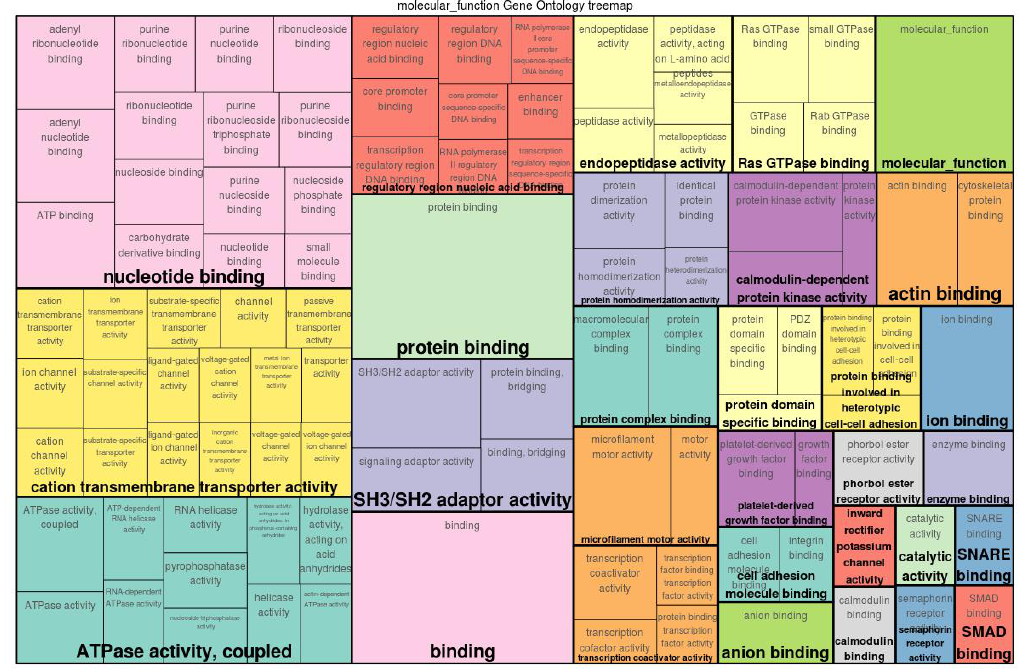
Figure 3. Gene Ontology (GO) treemap for genes associated with eggshell strength at Time Point 1 (ESS1). The boxes are grouped together based on the upper-hierarchy GO-term which is written in bold letters.